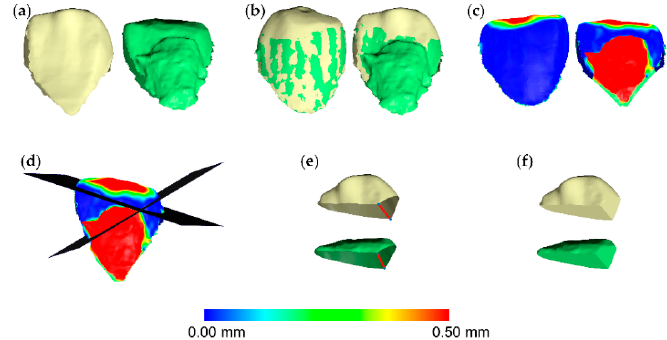
Figure 3. Tooth wear measurement process in a mandibular canine. ( a ) Tooth before (yellow) and after (green) tooth wear and retainer simulation. ( b ) Superimposed tooth crowns using the complete crown technique and setting C (20% estimated overlap) shown from the buccal (left) and the lingual (right) aspect. ( c ) Color coded distance map showing the tooth wear from the buccal (left) and the lingual (right) side. ( d ) Two levels (grey) used to simultaneously slice the two crowns. ( e ) Sliced tooth crowns with connected contralateral points (blue) in sharp edges (red line), splitting the hole in two parts to ensure identical hole filling process. ( f ) Holes filled to create watertight models, and thus, calculate